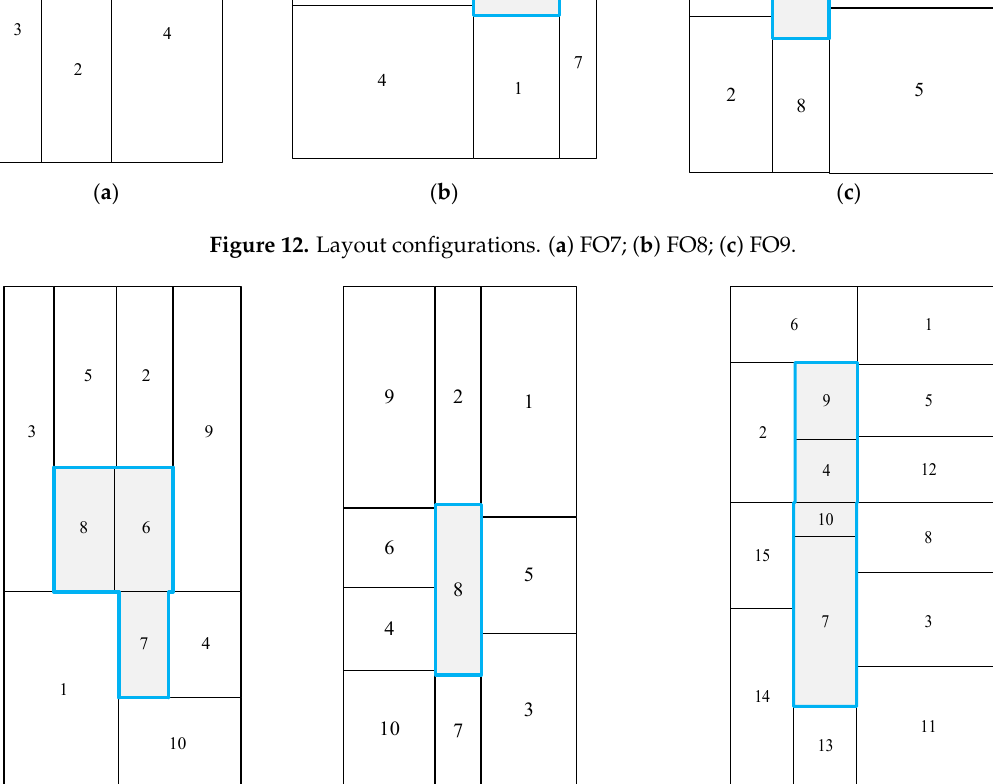
Figure 14. Layout configurations. ( a ) AB20; ( b ) KC25.